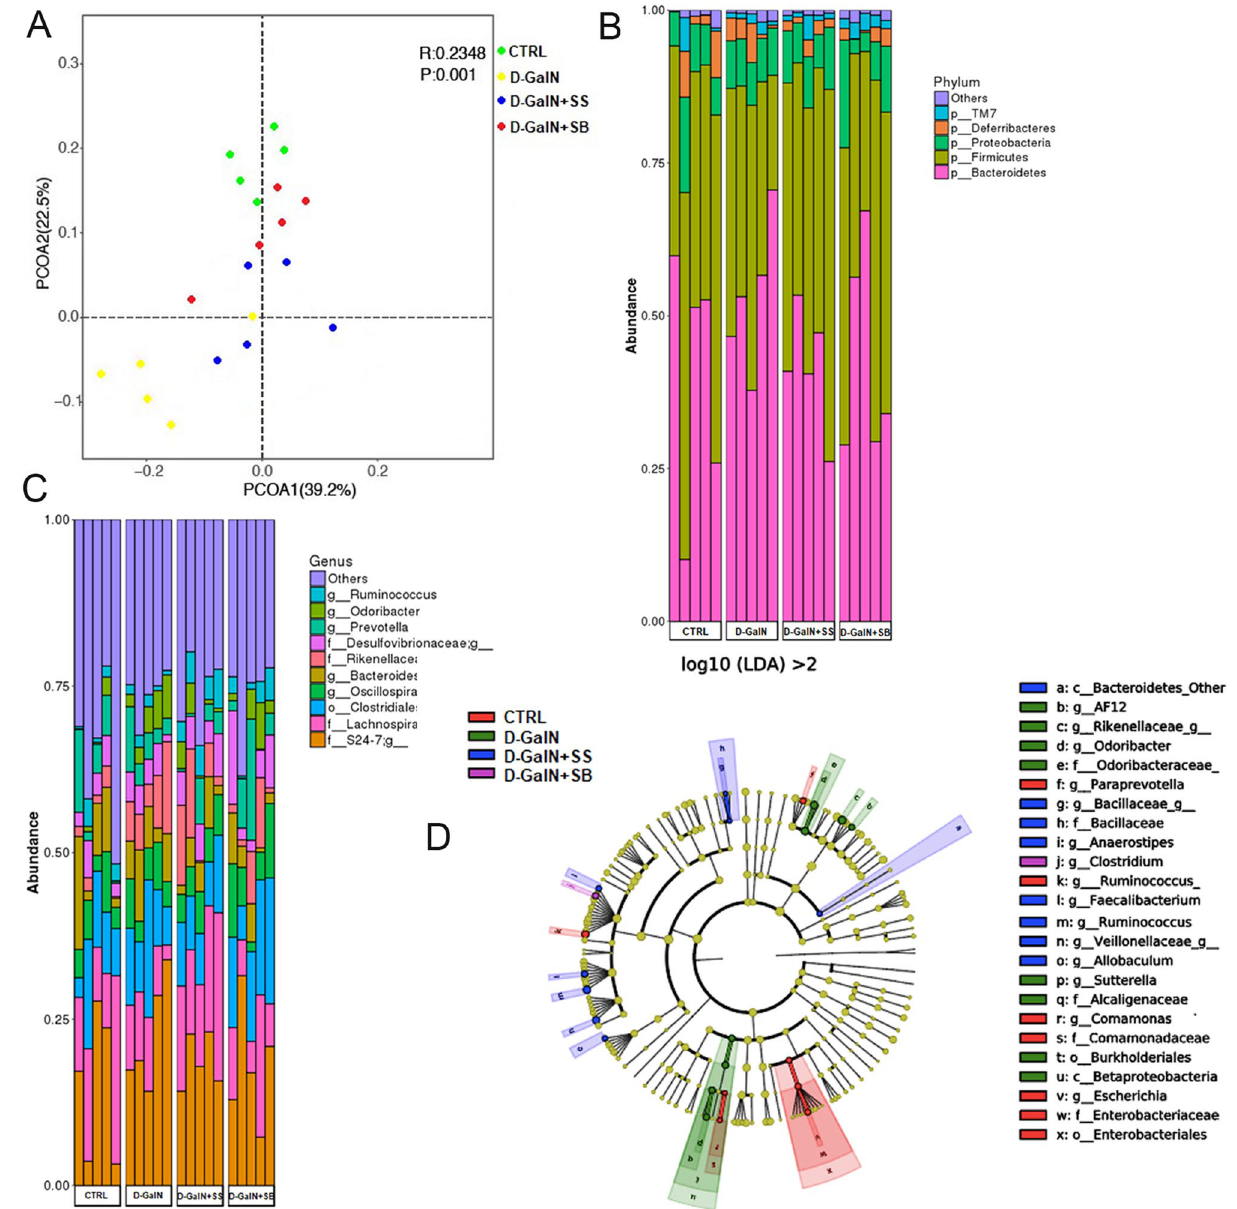
Figure 3. ( A ) Principal component analysis. ( B ) Gut microbiota at the pylums level. ( C ) Gut microbiota at the family level. ( D ) Results of LEfSe